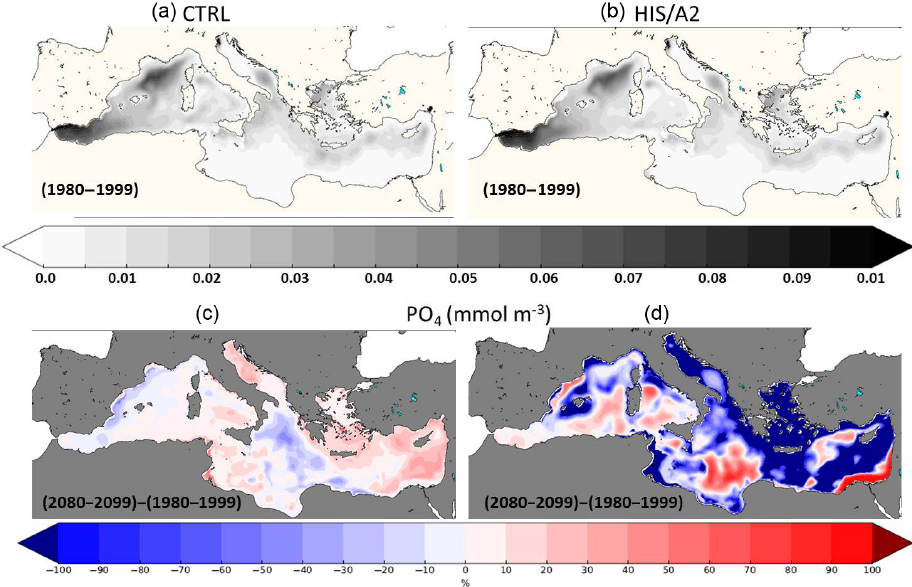
Figure 10. Present (1980–1999, a, b ) interannual average surface (0–200m) concentrations of phosphate (10 − 3 molm − 3 ) in the CTRL (a, c) and HIS/A2 (b, d) simulations. (c) and (d) show the percentage of relative difference in primary production between the